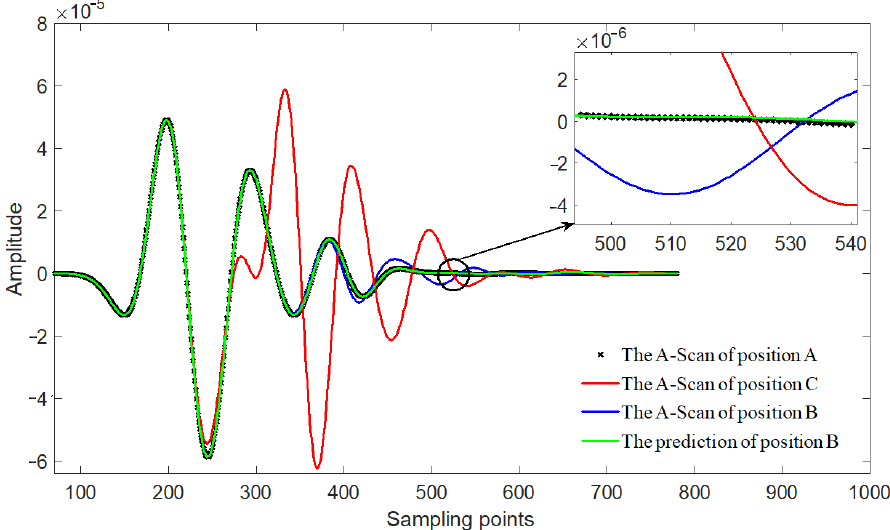
Figure 7. Comparison of prediction results with original A-Scan data.